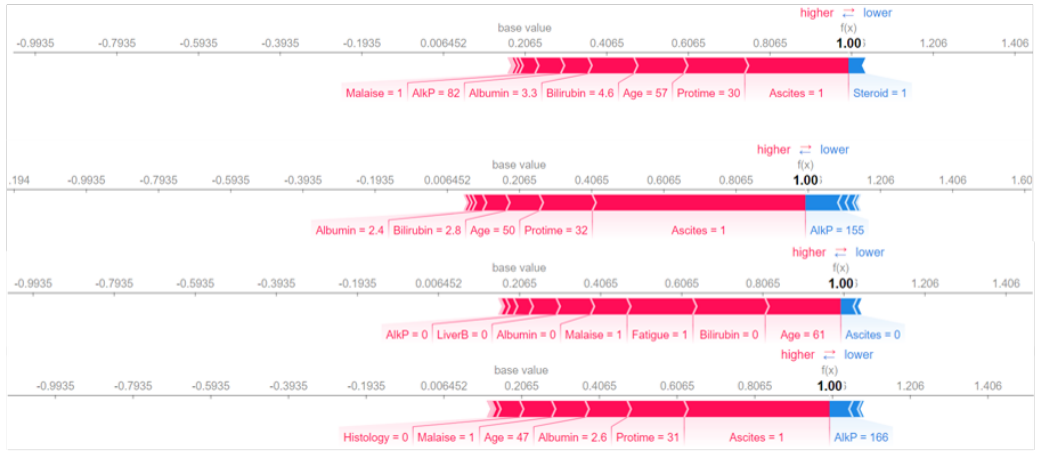
Figure 2. SHAP predictions generated using